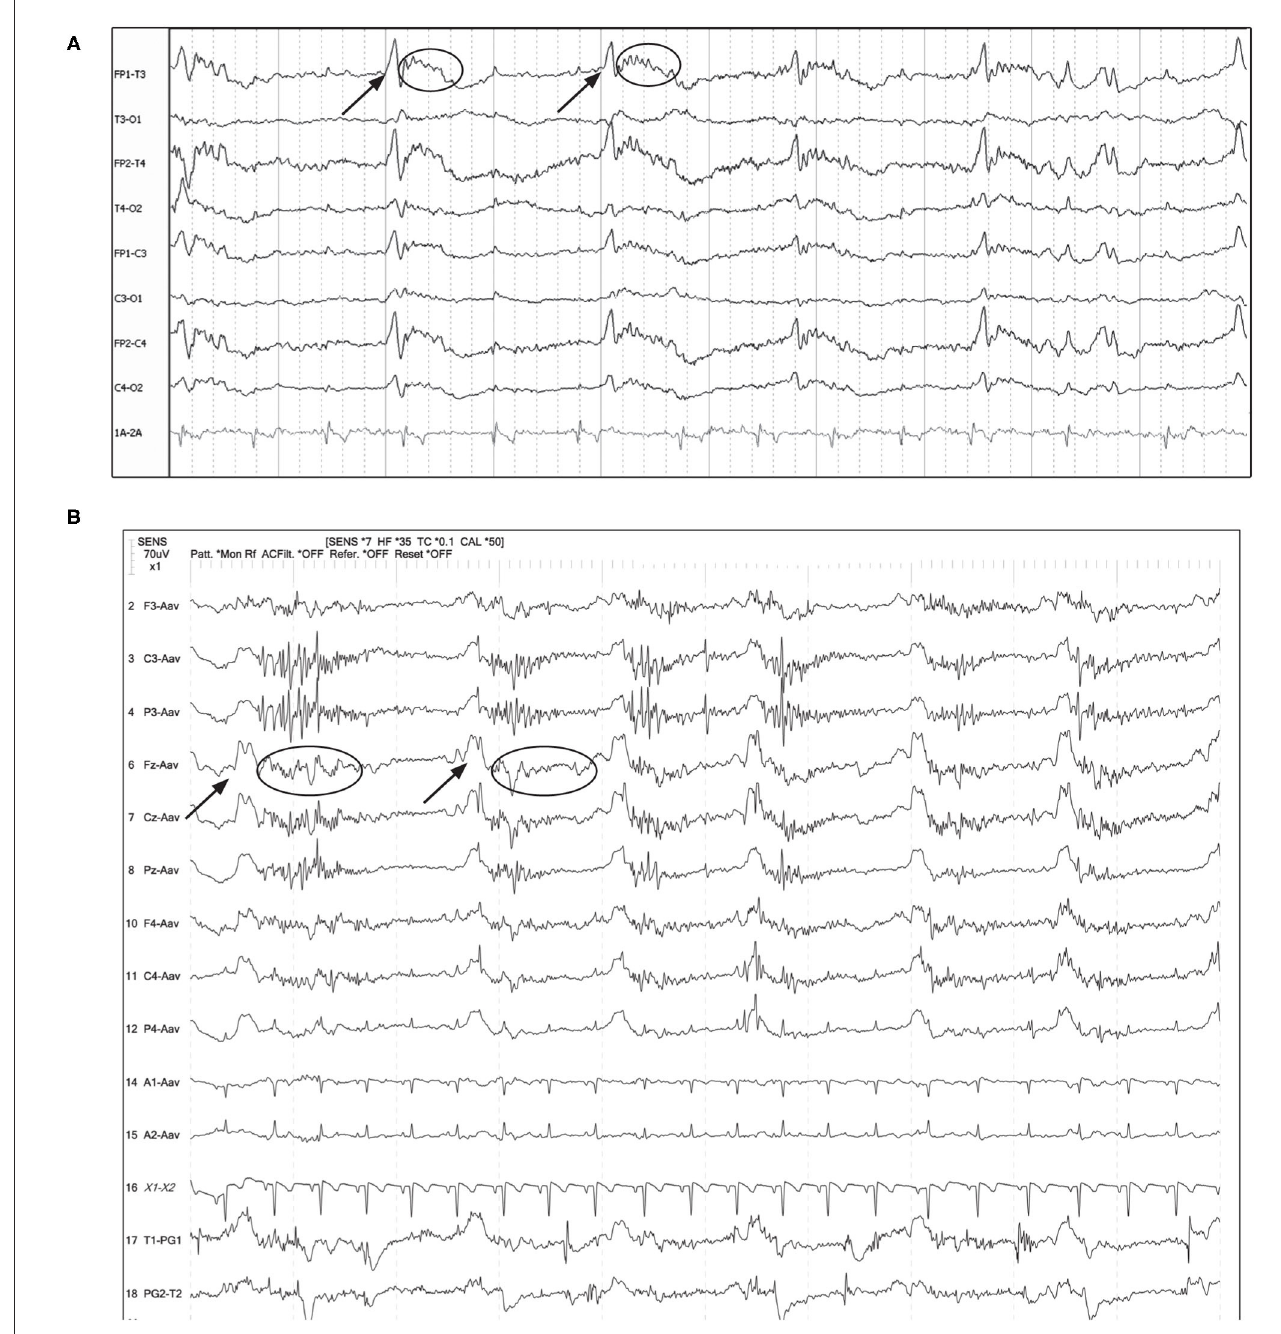
FIGURE7 Examples of GPDs (arrow) with apparent superimposed fast activity (circle), similar to the “ + F” modifier (Box 1). (A) Seven year old Swiss Mountain Dog presenting in SE, post-ictal changes noted on MRI, likely idiopathic epilepsy (Bipolar montage; HF 70Hz, sensitivity 2 uV/mm). (B) Two year old French bulldog with cluster seizures and MUO, 10min post-MDZ IV bolus. A left ear twitch was noted AFTER each PD and fast activity, in the interdischarge interval. ECG artifact is noted in channels 14 & 15 (Referential montage; HF 35Hz, sensitivity 7 uV/mm). MUO, meningoencephalitis of unknown